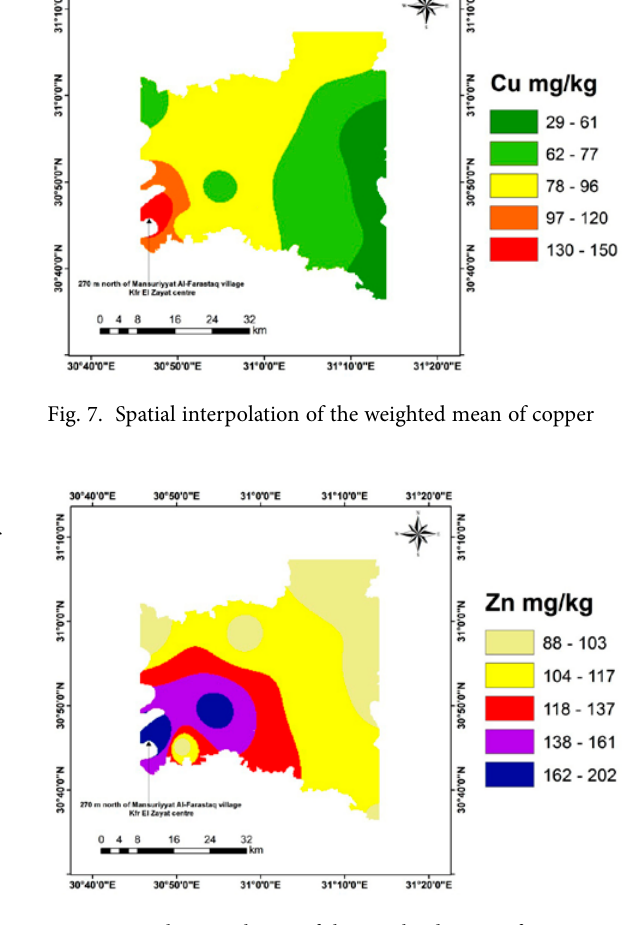
Fig. 8. Spatial interpolation of the weighted mean of zinc category, except for the first horizons of Profiles 2 and